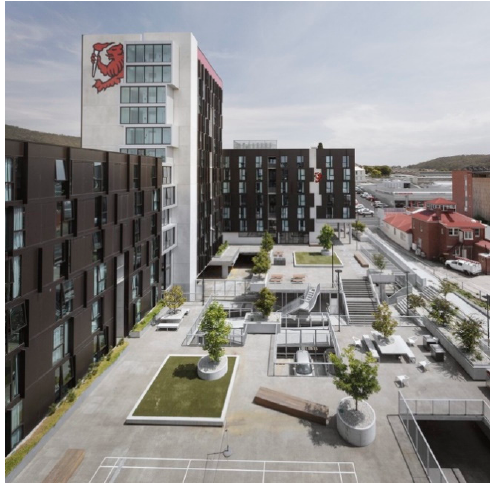
Figure 4. Aerial view of the proposed garden site and existing greenery in private and public areas. [Source, Terroir Architects].